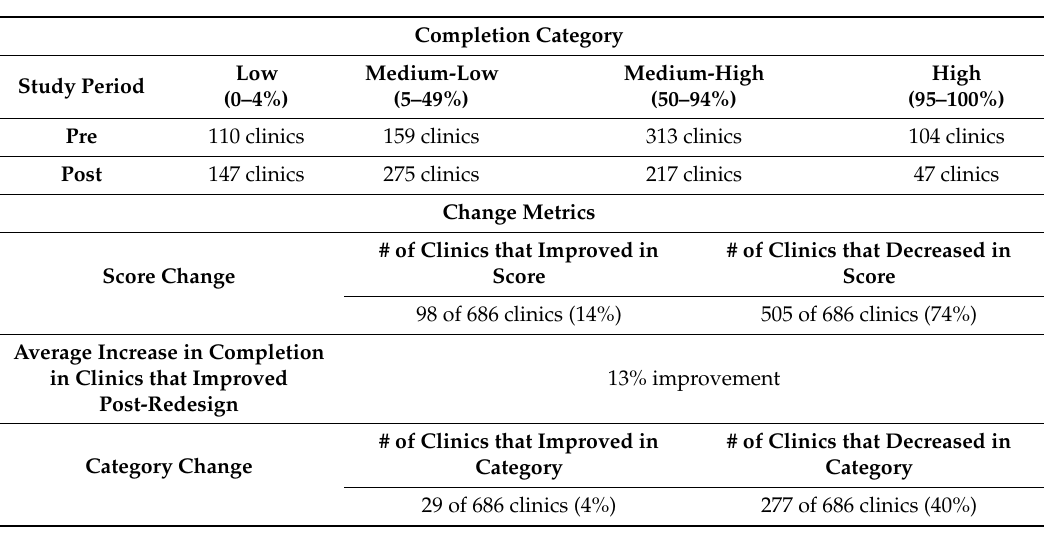
Table 5. Task Completion by